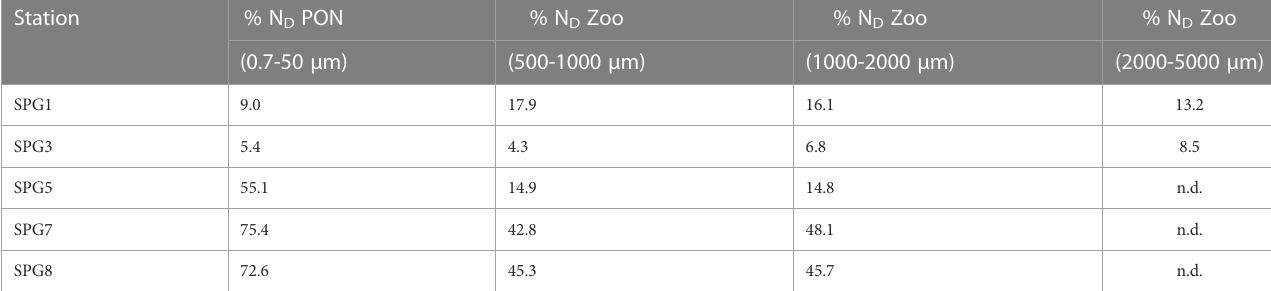
TABLE 2 Contribution of diazotrophic N (% N D ) to the particulate organic nitrogen (PON) and the three zooplankton size classes within the epipelagic layer.